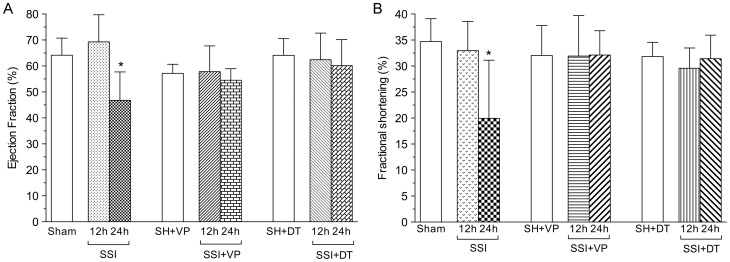
Verapamil and dantrolene restrained ejection fraction (EF) and fractional shortening (FS) changes induced by severe sepsis in mice.(The left ventricular ejection fraction and fractional shortening in untreated mice (Sham) or in mice treated with either verapamil (SH+VP) or dantrolene (SH+DT) at 12 and 24 hours after sham operation were absolutely identical regarding each procedure and computed and represented as a single column). A and B. The left ventricular ejection fraction and fractional shortening in mice submitted to CLP-induced sepsis were similar to the values in mice submitted to sham operation at 12 hours after surgical procedure. But the left ventricular ejection fraction and fractional shortening in SSI mice was markedly reduced in comparison with the mean values observed in sham controls at 24 hours after surgery. In contrast, the treatment with either verapamil or dantrolene abrogated the left ventricular ejection fraction and fractional shortening in SSI mice that presented mean values similar to those observed sham-operated mice treated with either verapamil or dantrolene and sham-operated untreated mice. (n = 7 to 10 in each group; *, P<0.01).